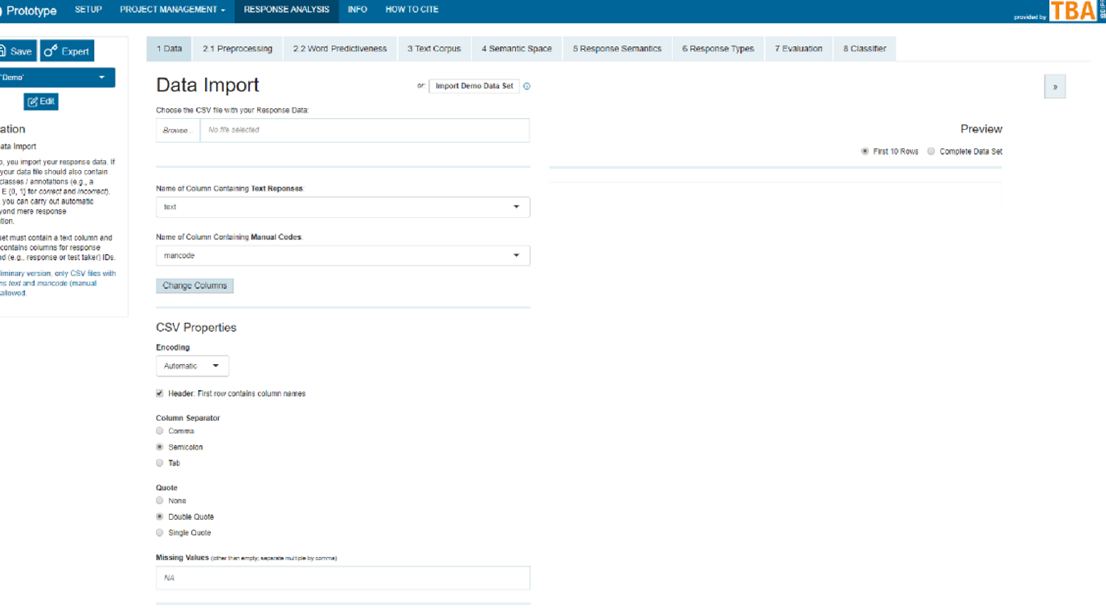
Figure 5. shinyReCoR